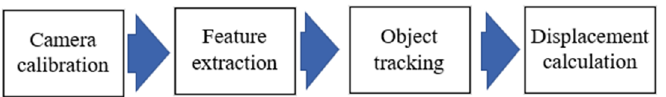
Figure 4. General framework of computer vision displacement monitoring. Figure 4 . General framework of computer vision displacement monitoring Figure 4 . General framework of computer vision displacement monitoring